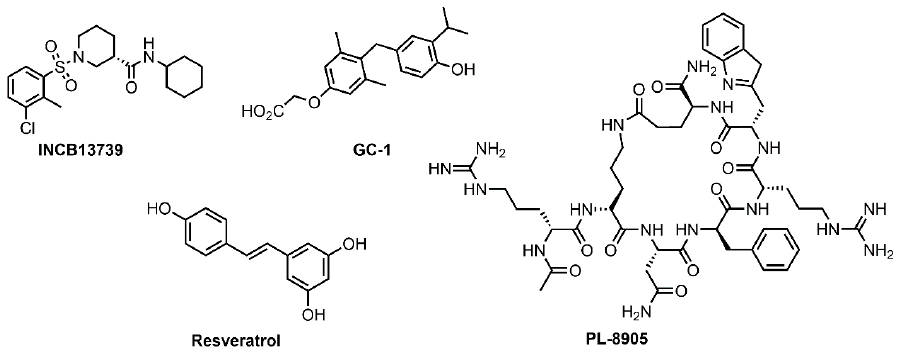
Figure 4. Drugs under development that increase energy